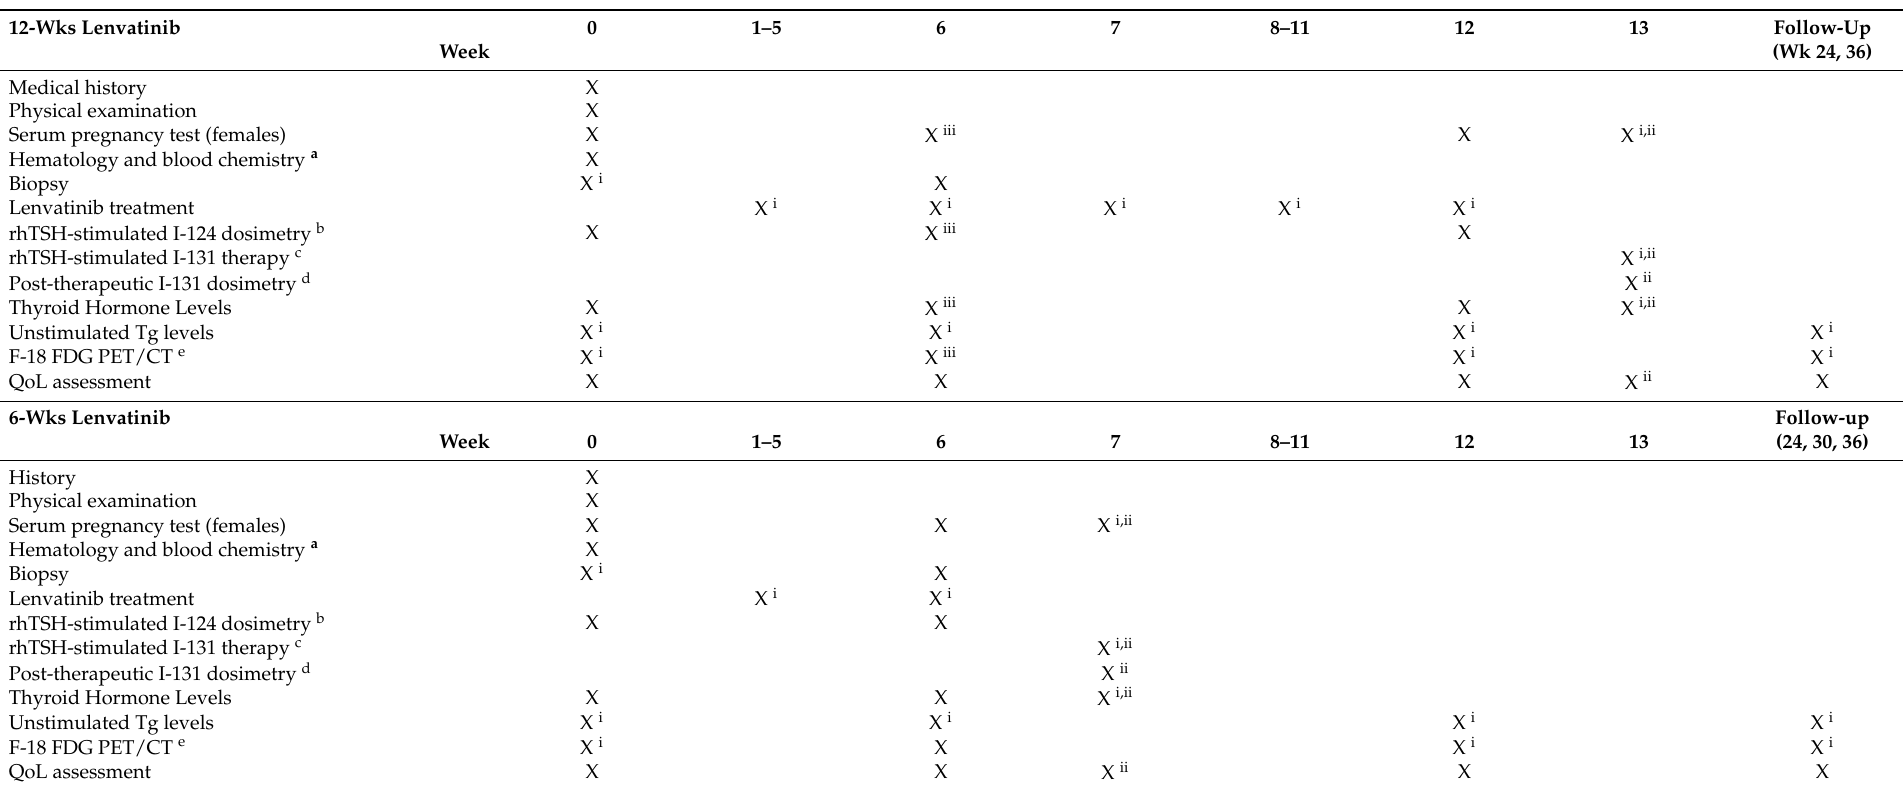
Table 1. Overview of all (standard and study) procedures in the RESET trial for cohort 1 and cohort 2 in case of 12 and 6-weeks lenvatinib